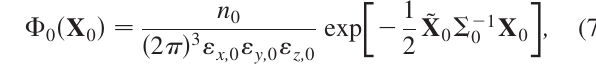
Fig. 2. The associated projection along the longitudinal coordinate z is